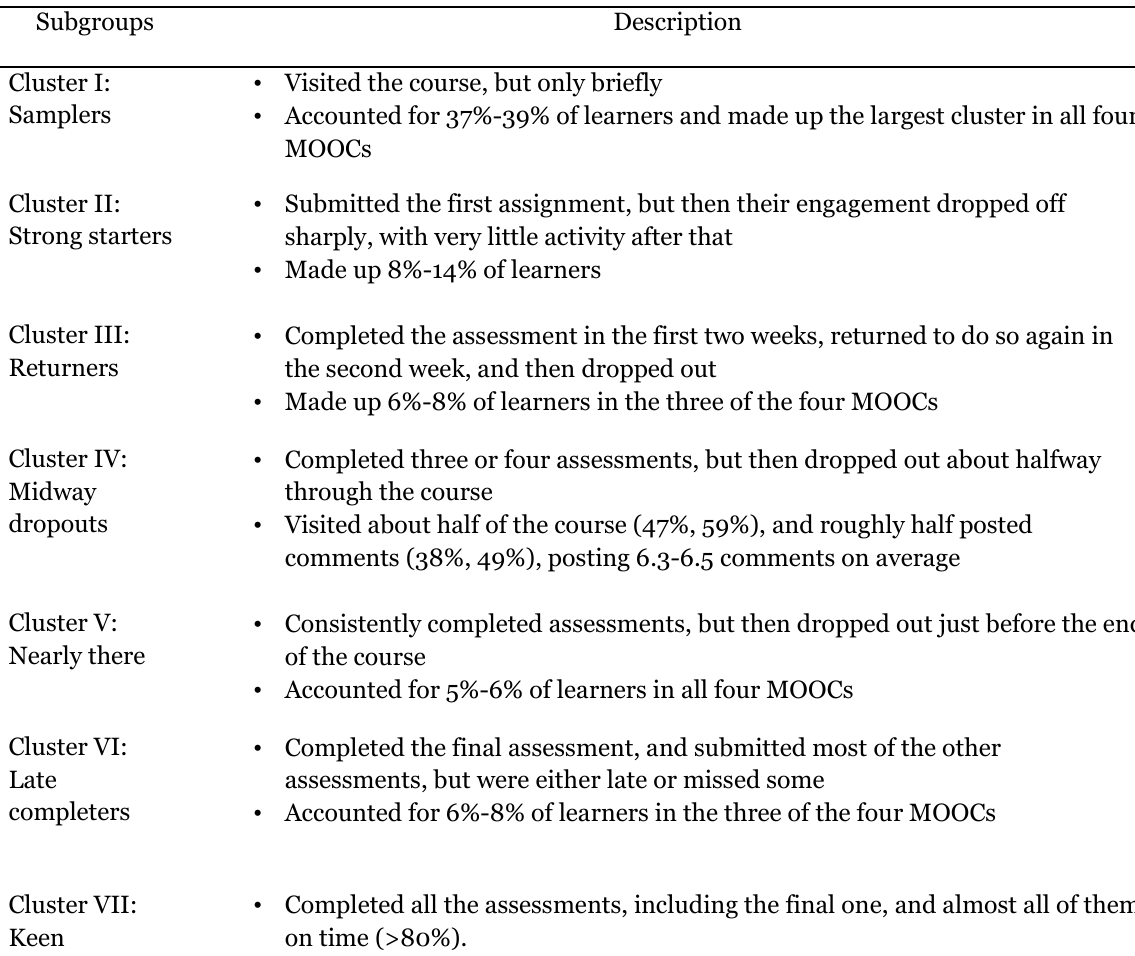
The Subgroups Found in MOOCs